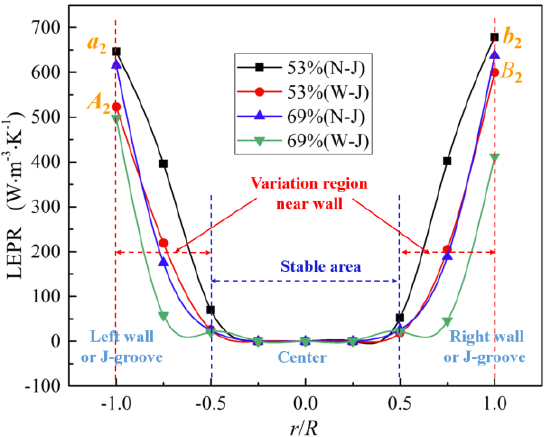
Figure 8. LEPR on section 2 of the draft tube at DPL and PL conditions with or without J-groove. Figure 8. LEPR on Section 2 of the draft tube at DPL and PL conditions with or without